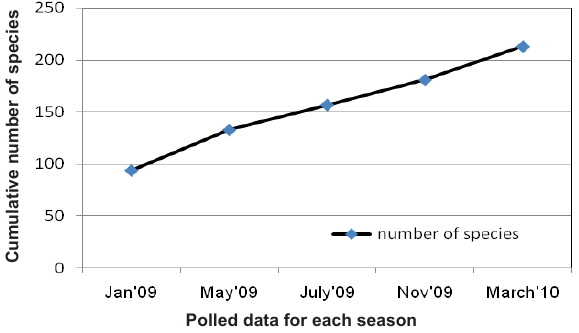
Figure 1. Species accumulation curve in sampling butterflies through different seasons in tropical lowland forests of Bhutan (January 2009–March